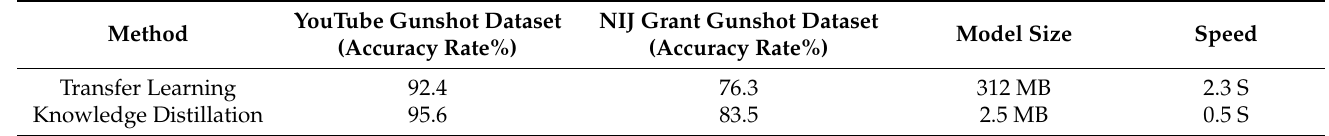
Table 6. Results of identification accuracy